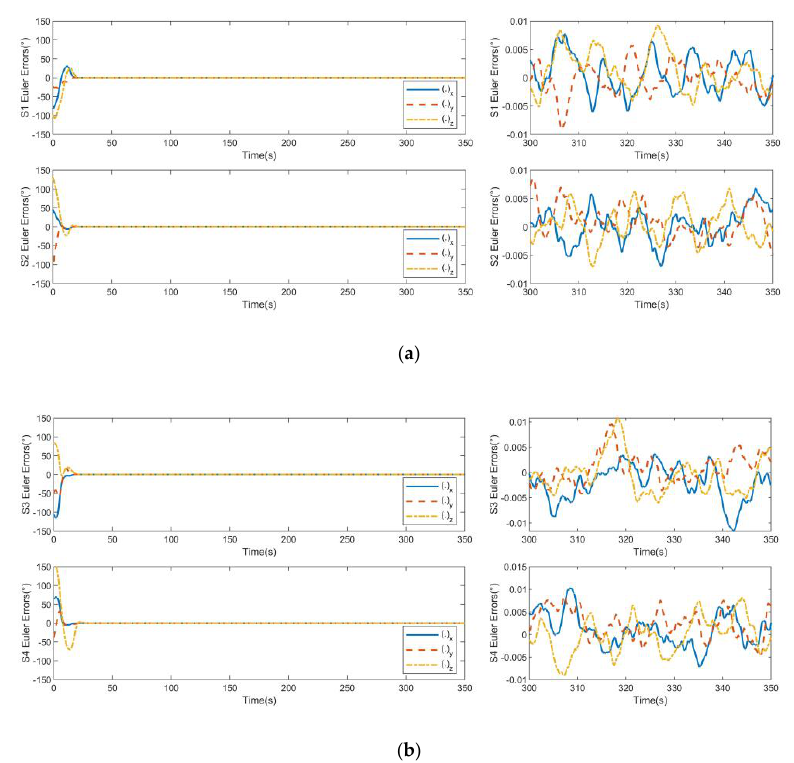
Figure 5. Euler errors for non-consistent collaborative control: ( a ) S1 Euler errors and S2 Euler errors; ( b ) S3 Euler errors and S4 Euler errors.